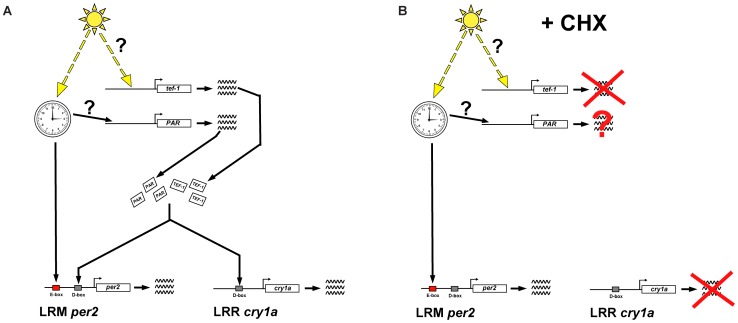
Contribution of de novo protein synthesis to light–induced clock gene expression.(A) Under normal conditions light exposure triggers expression of the gene encoding the PAR bZip factor, TEF-1. This in turn binds to D-boxes in the cry1a and per2 promoters and trans-activates gene expression. In parallel, light also entrains the circadian clock. Via binding of the CLOCK–BMAL complex, the clock regulates the E-box in the per2 promoter and thereby contributes to light induced gene expression [21]. The clock also regulates expression of the additional PAR bZip factors (PAR) that contribute to D-box driven transcription. (B) Upon light exposure and coincident inhibition of de novo protein synthesis by treatment with cycloheximide (+CHX), translation of TEF-1 and the other PAR bZip factors is prevented. Therefore, light-driven transactivation via the D-box enhancer of the cry1a promoter is abolished. However, light-induced expression of the per2 promoter persists due to regulation by the E-box. Specifically, upon cycloheximide treatment the core clock machinery directs increased activation via the E-box in a light dependent manner. We speculate that this up-regulation of E-box driven expression may also influence other clock-regulated genes including those encoding the PAR bZip factors.